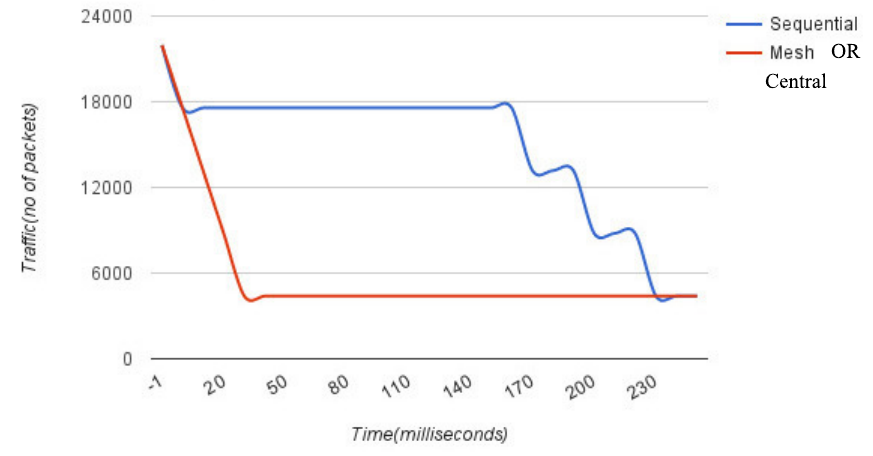
Figure 9. Linear vs. Mesh or Central: Shows a time based comparison of Policy Propagation delay between linear and mesh approach. Due to direct connection in mesh or central approach the mitigation effect is